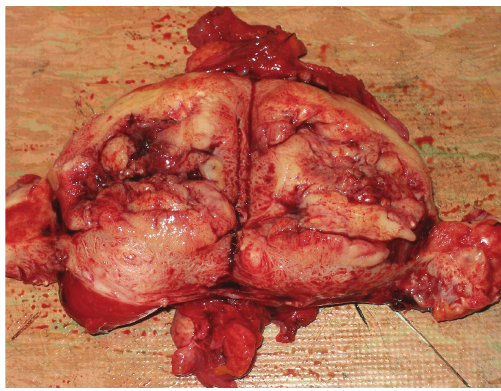
Figure 1: Adenocarcinoma of the uterine